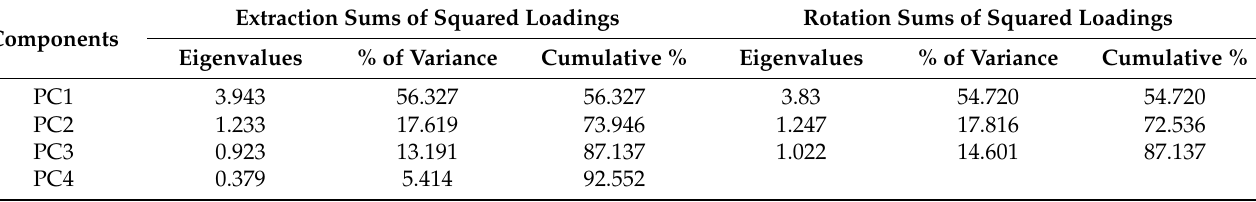
Table 6. Total variance explained and component matrices for heavy